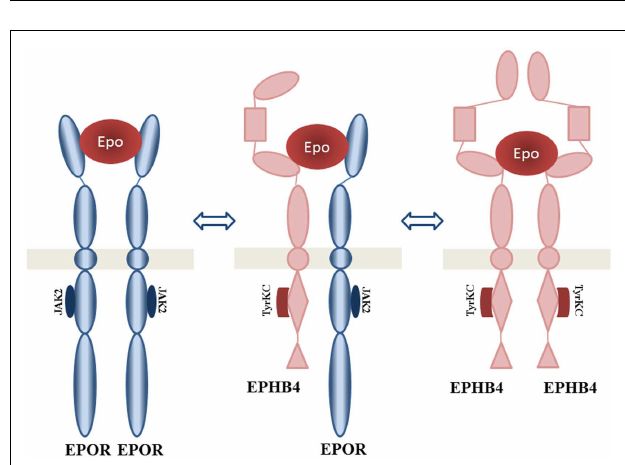
FIGURE 2 | EPOR- β cR receptor complex . Proposed structures of tissue-protective complexes are presented: heterotrimer including β cR homodimer with EPOR and heterodimer β cR with EPOR. Adapted from Brines and Cerami (47).